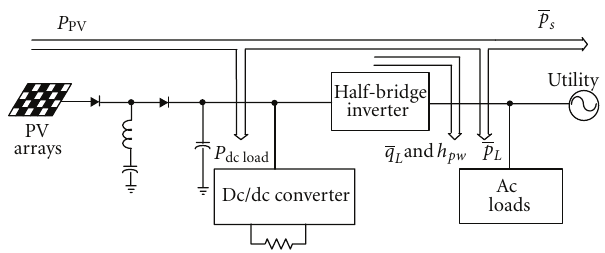
Figure 8: Illustration of power flow during the interval of high insolation.